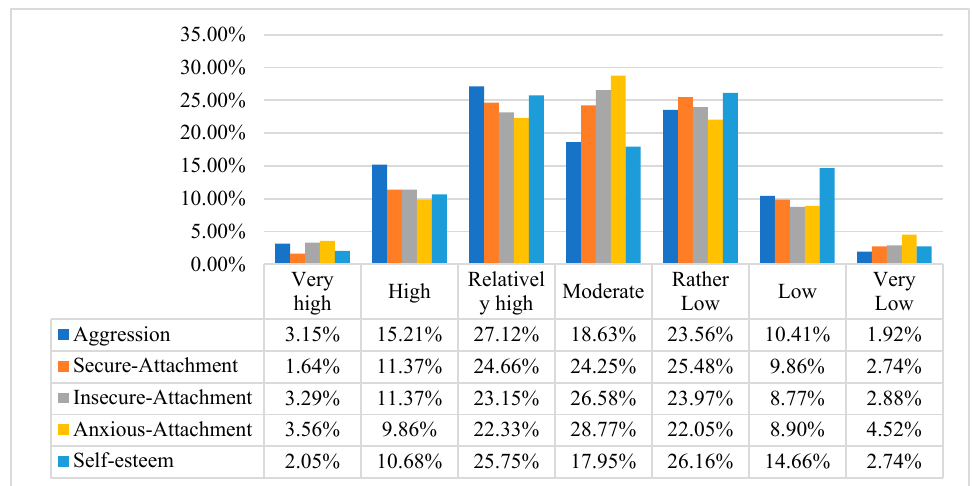
Figure 1. The distribution of scores of the variables.